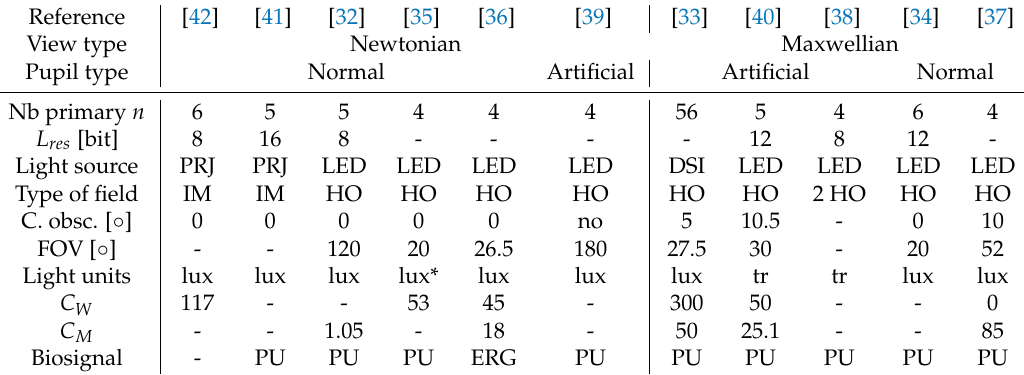
Table 2. The table is organized for the type of view. L res is the resolution of the luminance expressed in bits. C. obsc. corresponds to the central obscuration. PRJ, projectors; DS, digital spectral integrator; HO, homogeneous field; IM, imaging system; PU, pupil; PURK, Purkinje-tree percept. ∗ converts lux into photon/m 2 /s and